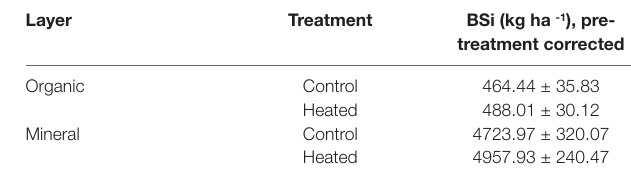
TABLE 2 | Soil BSi stocks. Soil BSi stocks were calculated for the top 10 cm in each plot, and the data reported here are means across all samples analyzed from all years during experimental treatment. Heated plot values are pretreatment-corrected.